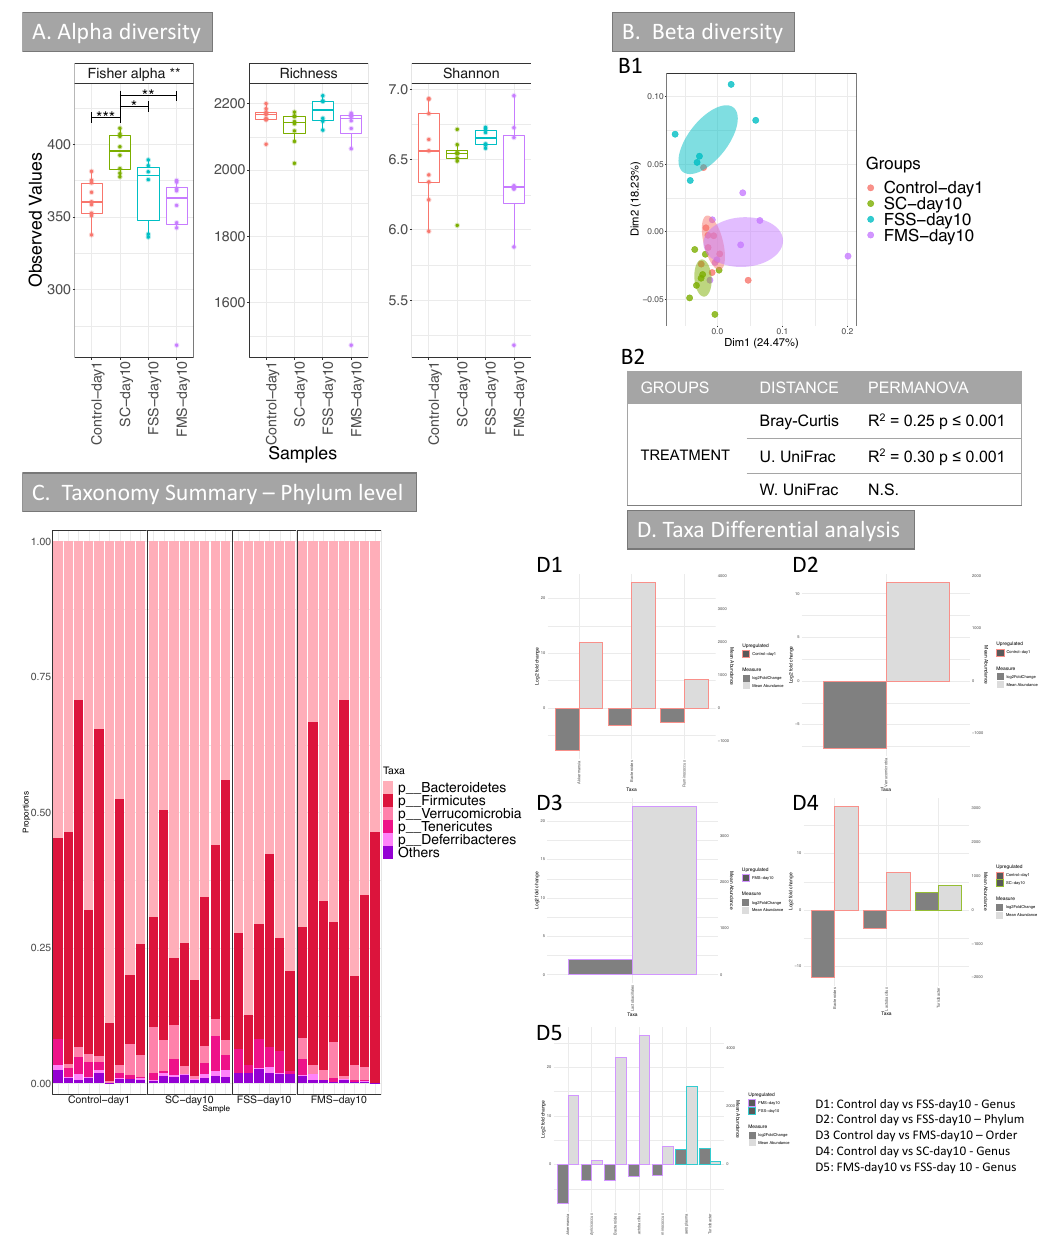
Figure 5. Alpha and Beta diversity, and taxonomy results of the intestinal microbiome (mice experiment). ( A ) Alpha diversity (OTUs level) of the intestinal microbiome from the 4 groups: Control-day 1, SC-day 10, FSS-day 10 and FMS-day 10. Three indices were considered: Fisher alpha (a parametric index that models species’ abundance as logseries distribution), richness (number of species) and Shannon index (a widely used index that considers species’ abundance and evenness). Pair-wise ANOVA was calculated between the groups and if significant, stars are shown on top (* p < 0.05, ** p < 0.01 and *** p < 0.001). ( B ) Beta diversity results; ( B1 ) Principal Co-ordinate Analysis (PCOA) showing clustering of samples. The chart was produced using unweighted UniFrac (UniFrac) at OTUs level. Ellipses are 95% confidence interval of standard error. The table in ( B2 ) summarises PERMANOVA results for all the distances, Bray-Curtis, unweighted UniFrac (U. UniFrac) and weighted (W. UniFrac). R2 refers to the percentage of variability among samples’ microbiome that can be explained by that factor/metadata. ( C ) Taxonomy summary for stool at phylum level. ( D ) Taxa differential analysis at phylum, order and genus levels are presented through bar charts; these show Log2 fold change between the groups compared, ( y axis on the left and dark grey bar) and the mean abundance across all the samples ( y axis on the right and light grey bar), details of the comparisons per chart are in the right bottom of the chart. Detail of taxa differential analysis results, including p values and adjusted p values, is in Supplementary Table S3. FS = ferrous sulphate and FM = ferric